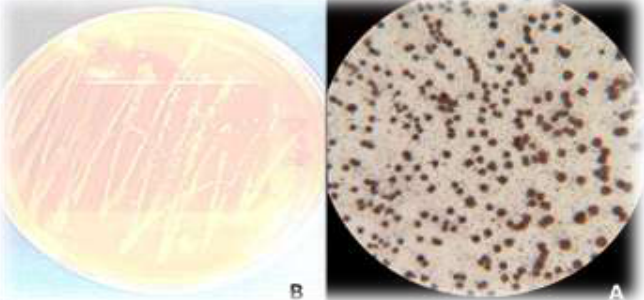
Figure 2: A- PHA granules (black section) on A.lwoffii G3 were noticed. Under a 100X oil immersion objective with Sudan black B stain. B-Fluorescent PHA under UV light after staining bacteria with Nile